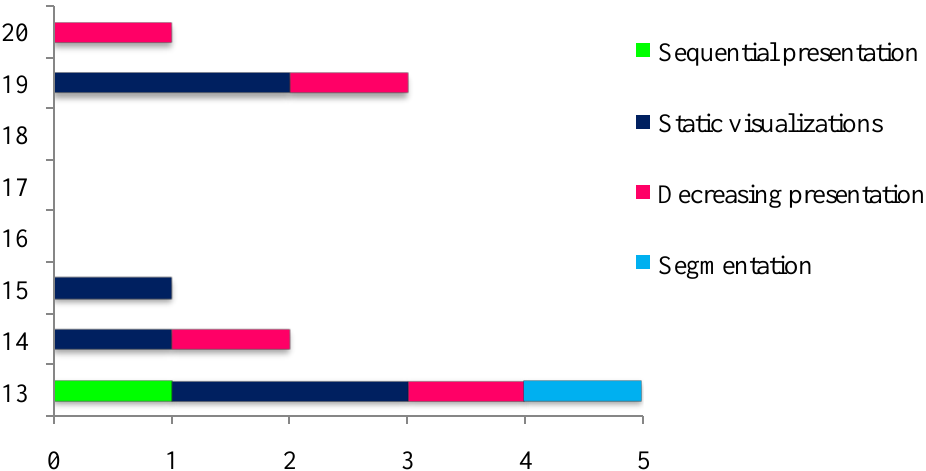
Figure 2. The distribution (by year and number) of studies focused on the role of instructional designs when learning tactical scenes of play through dynamic visualizations.